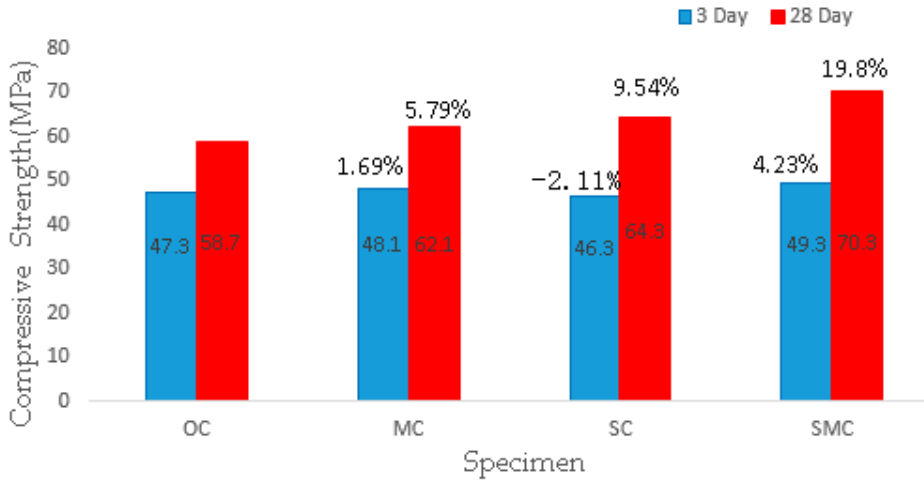
Figure 6. Compressive strength at 3 and 28 days.